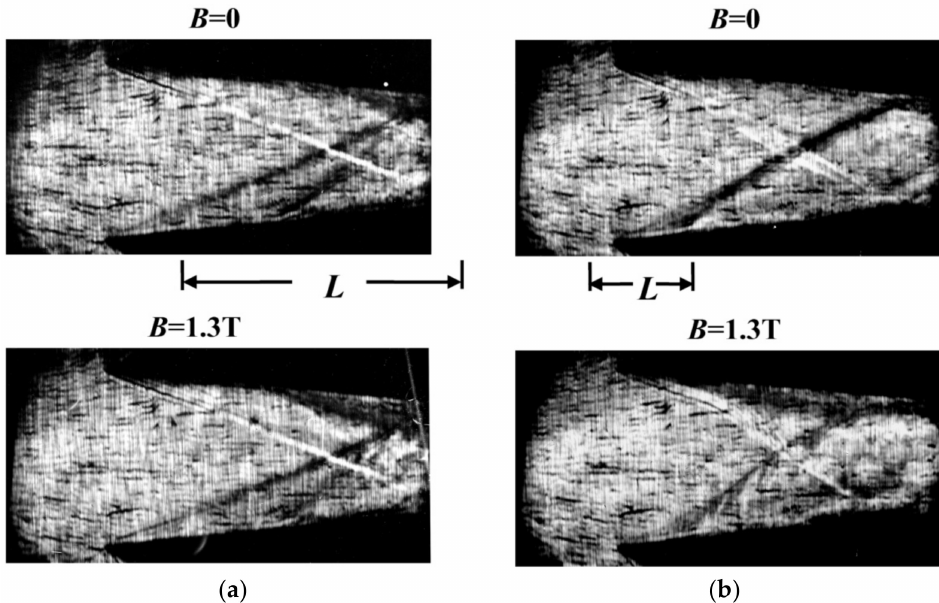
Figure 9. Schlieren patterns of interaction at the transverse current: ( a ) in the diffuser without an inlet, j 4,5,6,7 = 7 × 10 5 A/m 2 ; ( b ) in the diffuser inlet, j 3 = 3.8 × 10 5 A/m 2 . Table 1. Parameters of impact in the case of the transverse current. Interaction